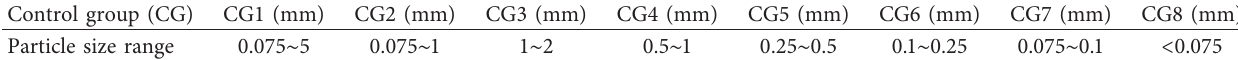
Table 1: The particle size ranges of different grain groups.